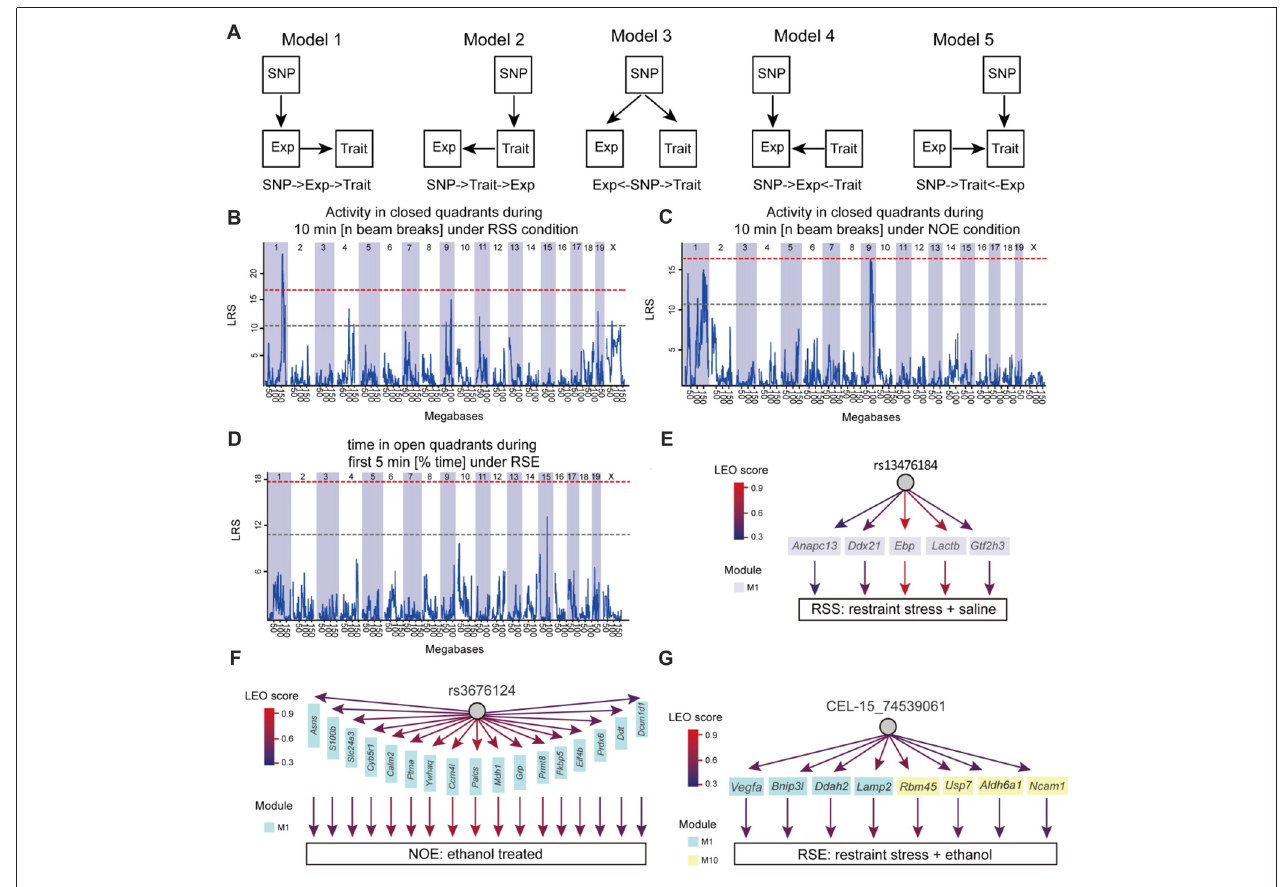
FIGURE 5 | Causative analysis. (A) Schematic diagram showing SNP → Module → Phenotype causality analysis. Five possible Single Anchor Models were shown. (B–D) Quantitative trait locus (QTL) mapping for three conditions, including No restraint stress (NOS), RSS and RSE. (E–G) The causal network was constructed by SEM methods for NOE, RSS and